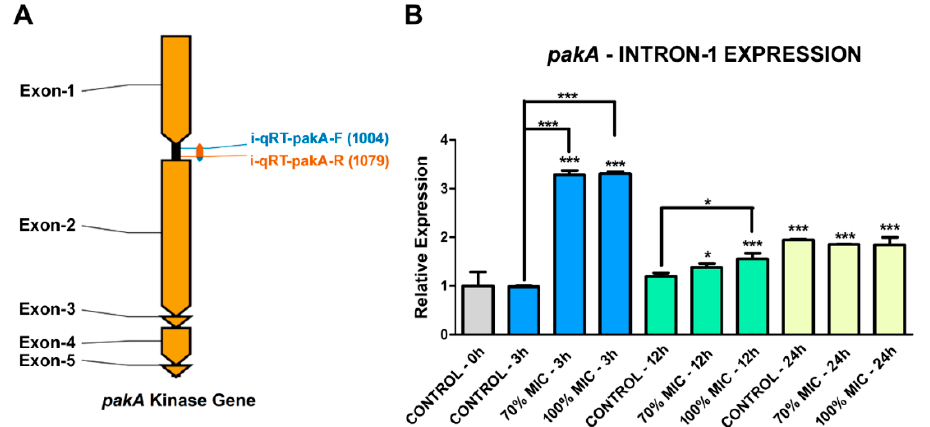
Figure 4. qRT-PCR analysis of the intron 1 retention levels of the T. rubrum pakA/ste20 gene. ( A ) Graphical representation of the pakA/Ste20 kinase gene with its five exons (dark yellow), four introns (black), and the primer-binding sites used for amplification of the intron 1 retention (blue and orange arrows). ( B ) Intron 1 retention levels of the T. rubrum pakA/ste20 gene, incubated in the presence of 70% and 100% UDA MIC for 3, 12, and 24 h using ANOVA followed by Tukey’s post hoc test (* p < 0.05; *** p < 0.001).